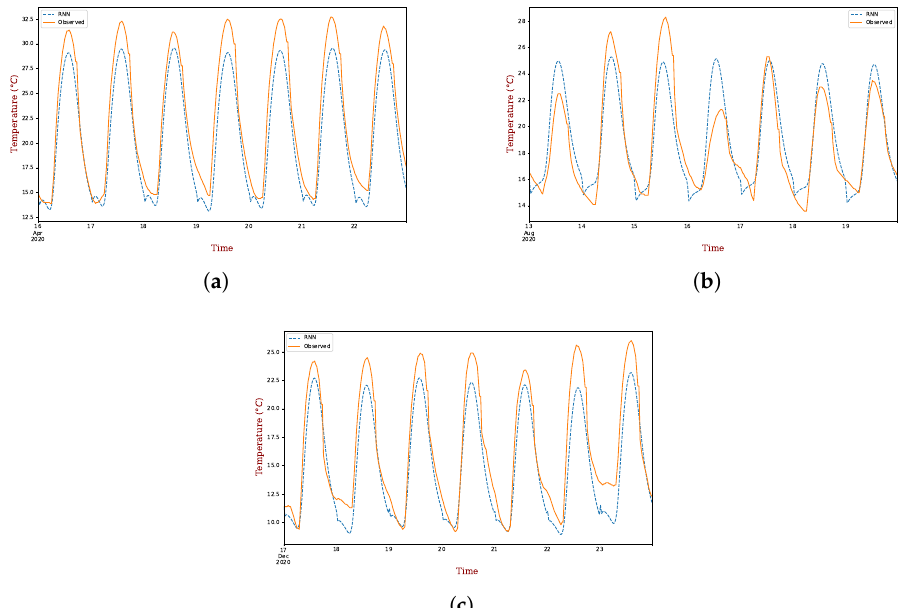
Figure 14. Temperature prediction for three weeks of 2020 with RNN. ( a ) Week 16. ( b ) Week 33. ( c ) Week 51. Table 4. Hyperparameter values for grid-search.